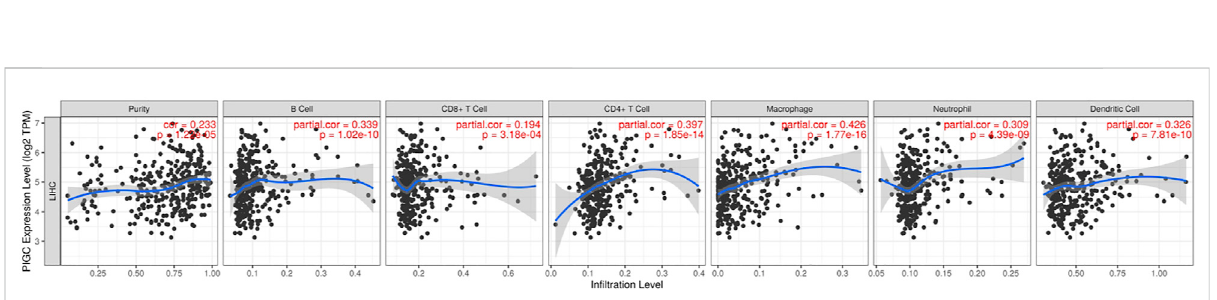
FIGURE 8 Correlation of PIGC expression with immune in fi ltration level in HCC. PIGC expression is signi fi cantly positively related to tumor purity and has signi fi cant positive correlations with in fi ltrating levels of B cells, CD8 + T cells, CD4 + T cells, macrophages, neutrophils, and dendritic cells in COAD.